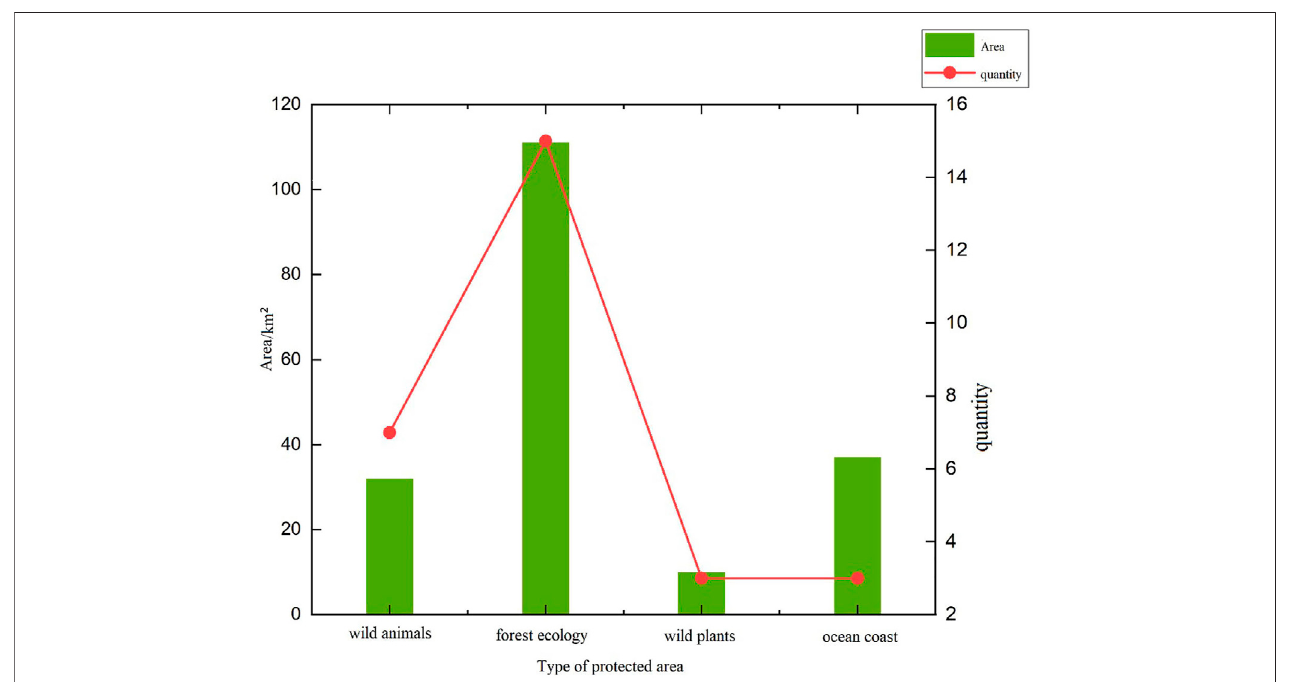
FIGURE 7 | Forest disturbance area of different types of protected areas.